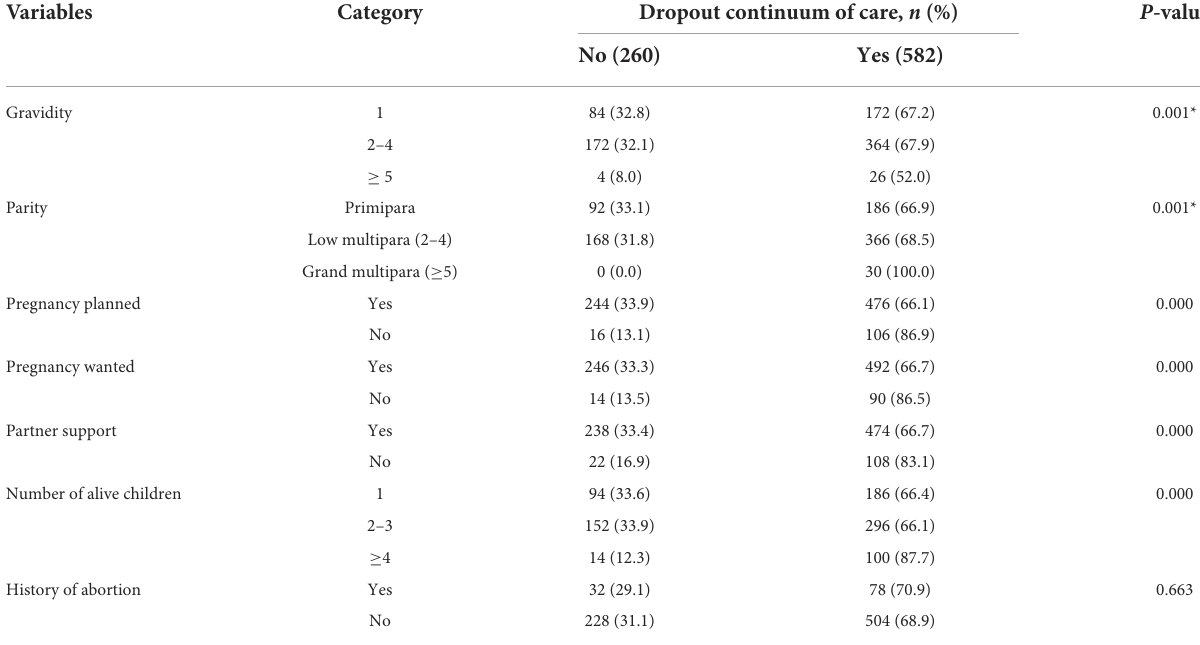
TABLE 2 Reproductive and obstetric characteristics by dropout from continuum of care in Debre Berhan town, northeast Ethiopia.